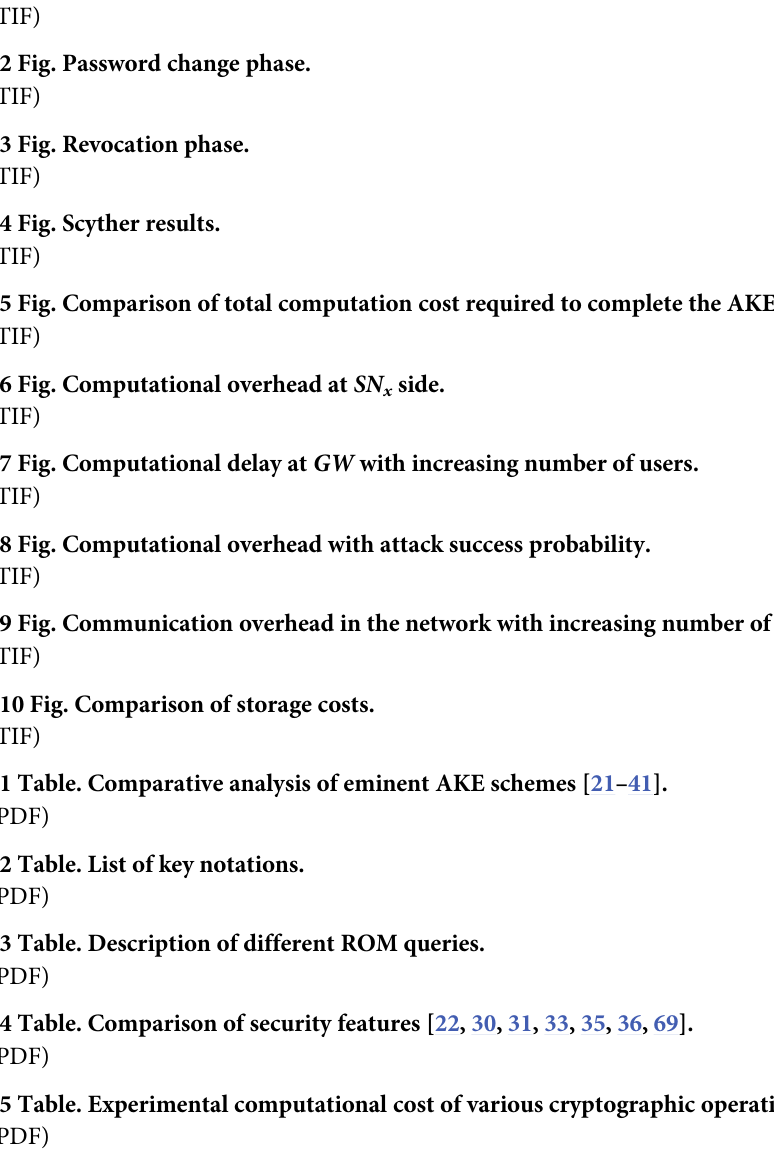
S5 Table. Experimental computational cost of various cryptographic